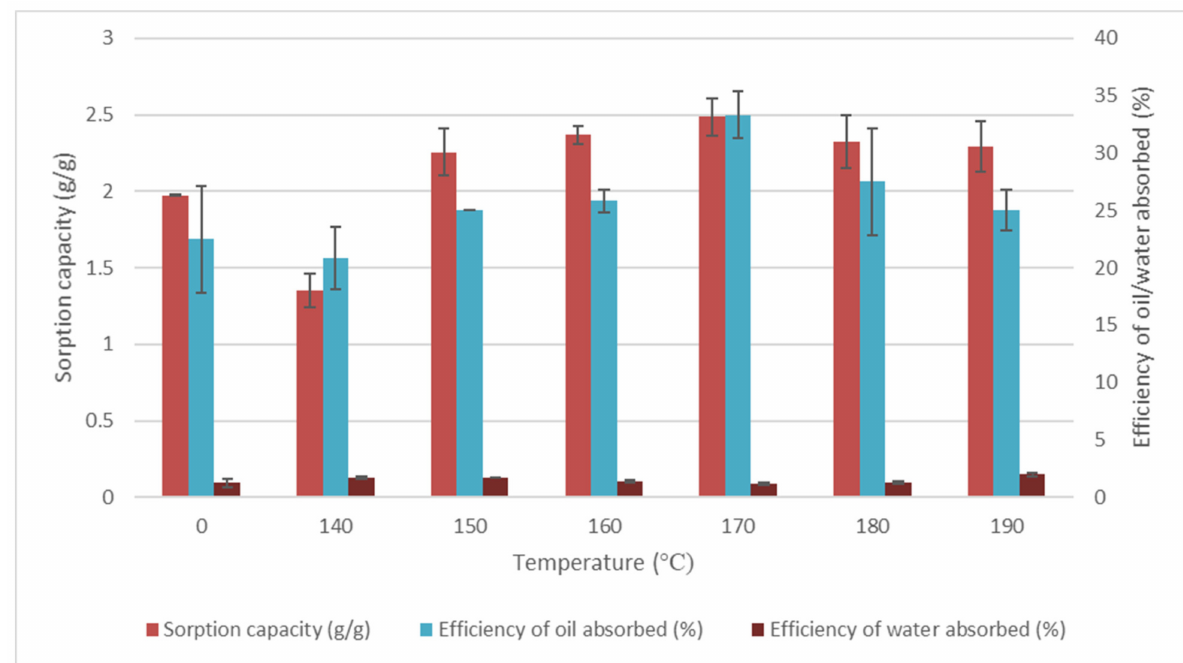
Figure 5. Effects of temperature on EFB treated fibre. Data obtained were the average efficiency of oil absorbed (%), the efficiency of water absorbed (%), and sorption capacity (g/g) on temperature. Vertical bars indicate SEM of three replicates.